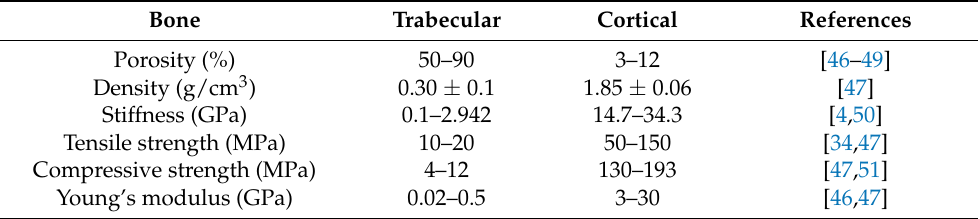
Table 1. Mechanical properties, porosity, and density of human cortical and trabecular bone.